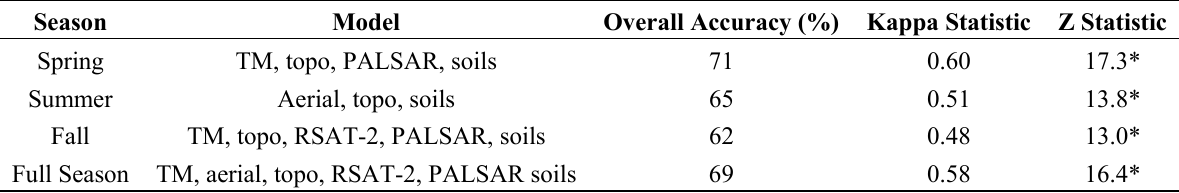
Table 12. Error matrix summaries of the best seasonal random forest models for the Level 2